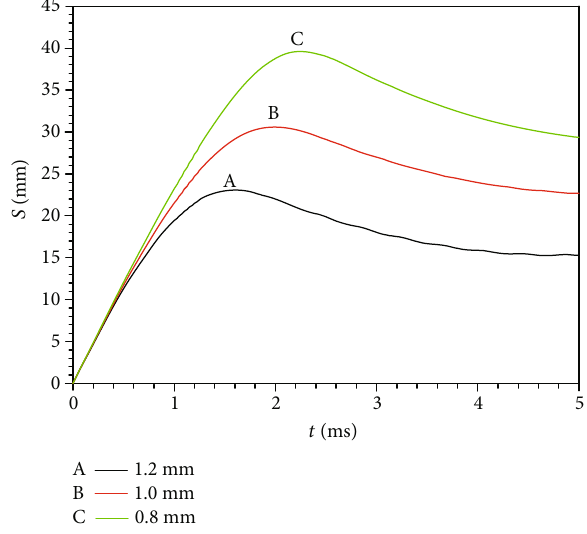
Figure 8: Comparison of displacement-time curves of the ascending object for tubes of di ff erent wall thicknesses.